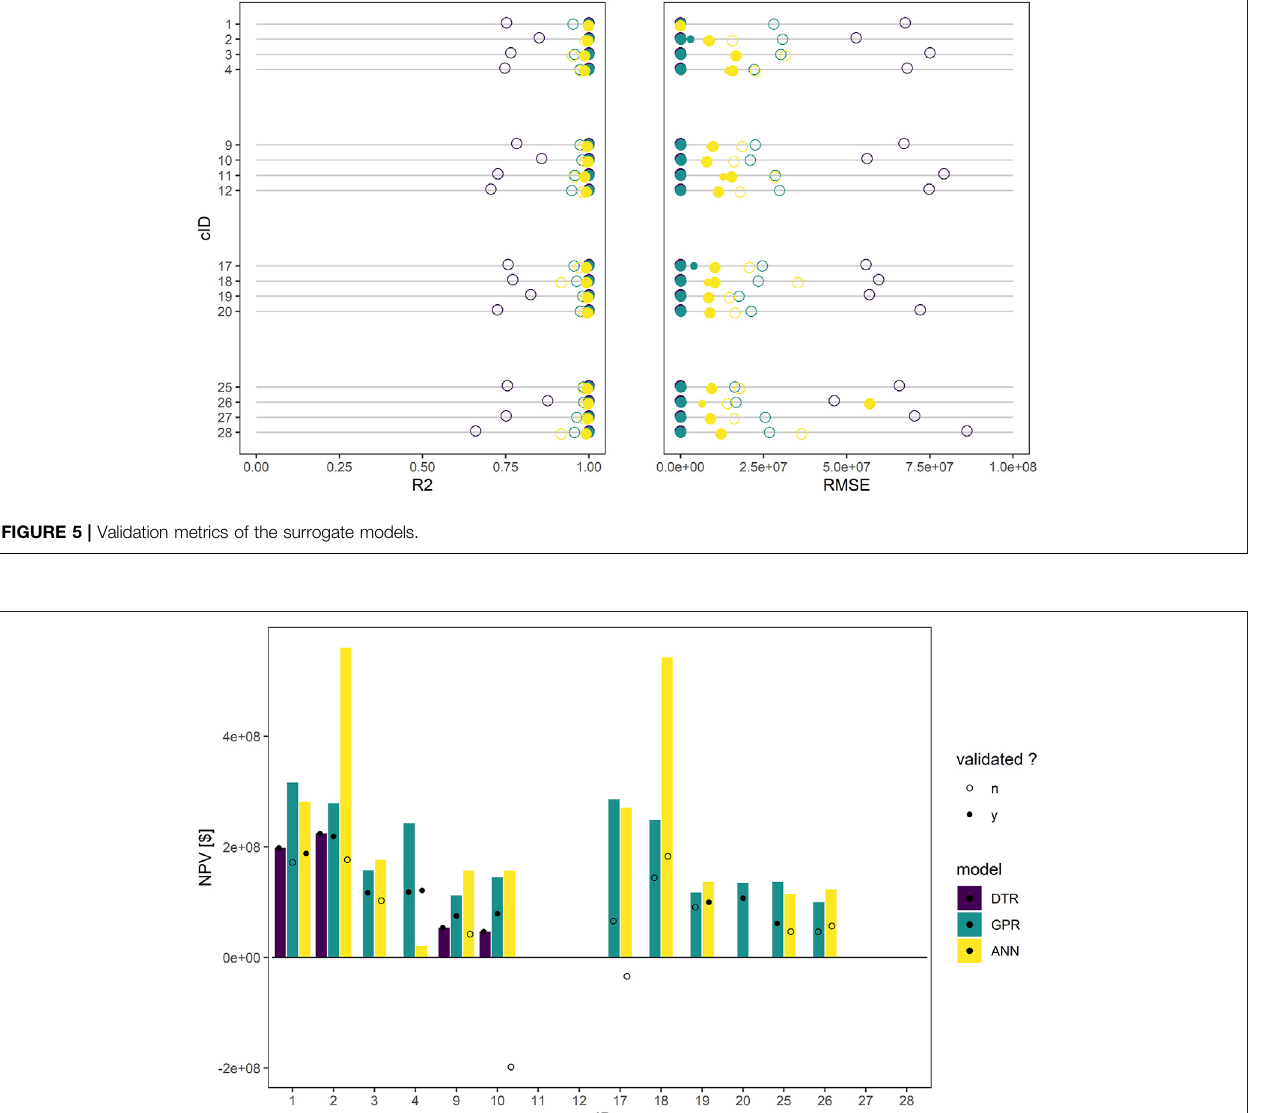
Frontiers in Chemical Engineering |